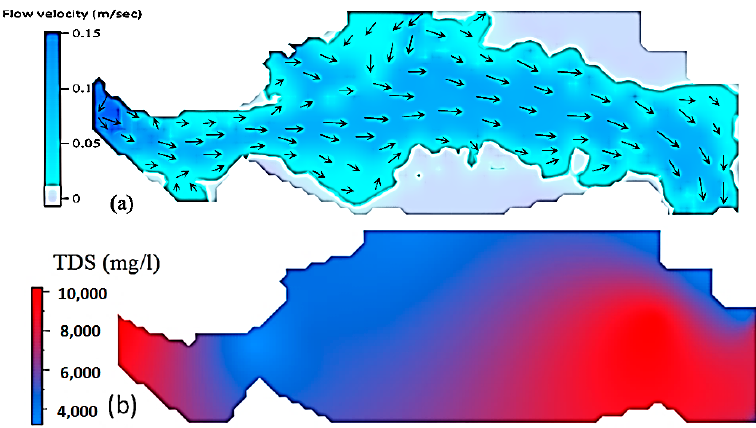
Figure 6. Distribution patterns of the flow velocity and TDS for the average inflow (Case 15). ( a ) Velocity pattern. ( b ) TDS pattern.